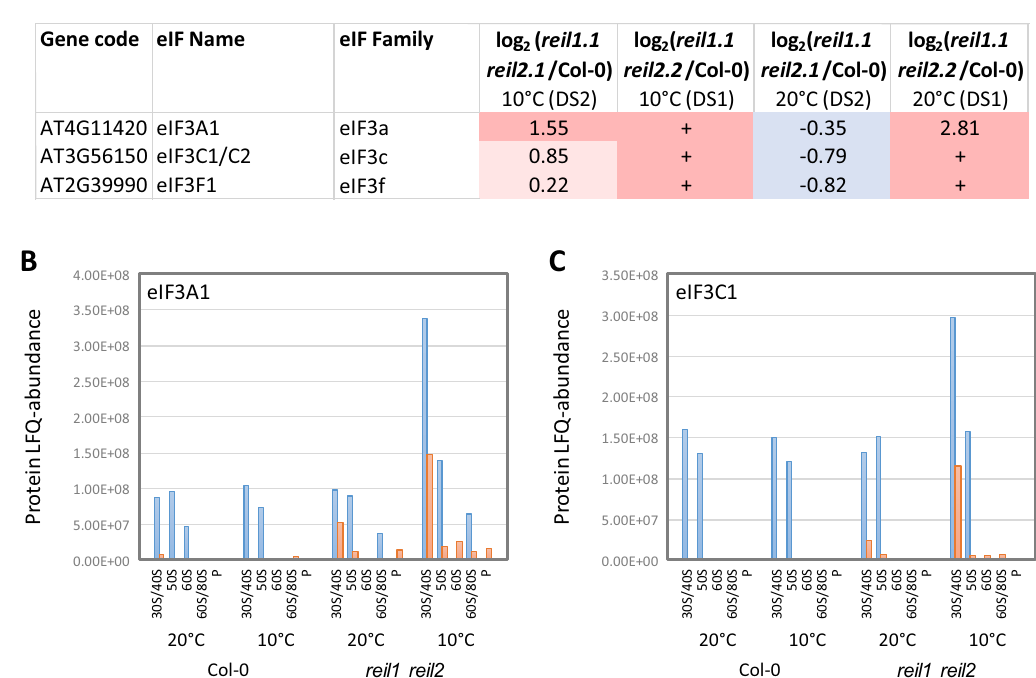
Figure 11. Changes of the composition of translation initiation factor 3 proteins in the non-translating 40S fraction of the reil1 reil2 double mutants 7 days after shift to 10 °C and prior to cold shift at 20 °C. ( A ) Shared changes at 10 °C between reil1-1 reil2-1 (DS2) and reil1-1 reil2-2 (DS1). Log 2 -fold changes between mutants and Col-0 wild type in the 30S/40S fractions are calculated after normalization of protein LFQ-abundances by abundance sums of all detected 40S RPs. Presence in mutants relative to absence in Col-0 and log 2 -fold increases > 1 are color-coded red, increases < 1 are light red. Absence relative to presence in Col-0 and log 2 -fold decreases < − 1 are color-coded blue, decreases > − 1 are light-blue. ( B ) Distribution of eIF3A1 LFQ-abundances across the sampled ribosome fractions and analyzed conditions (Experiment DS1, orange; experiment DS2 blue). ( C ) Distribution of eIF3C1 LFQ-abundances across the sampled ribosome fractions and analyzed conditions (Experiment DS1, orange; experiment DS2, blue). Note the abundance maxima in the 30/40S fractions that may contain 40S subunits and 43S pre-initiation